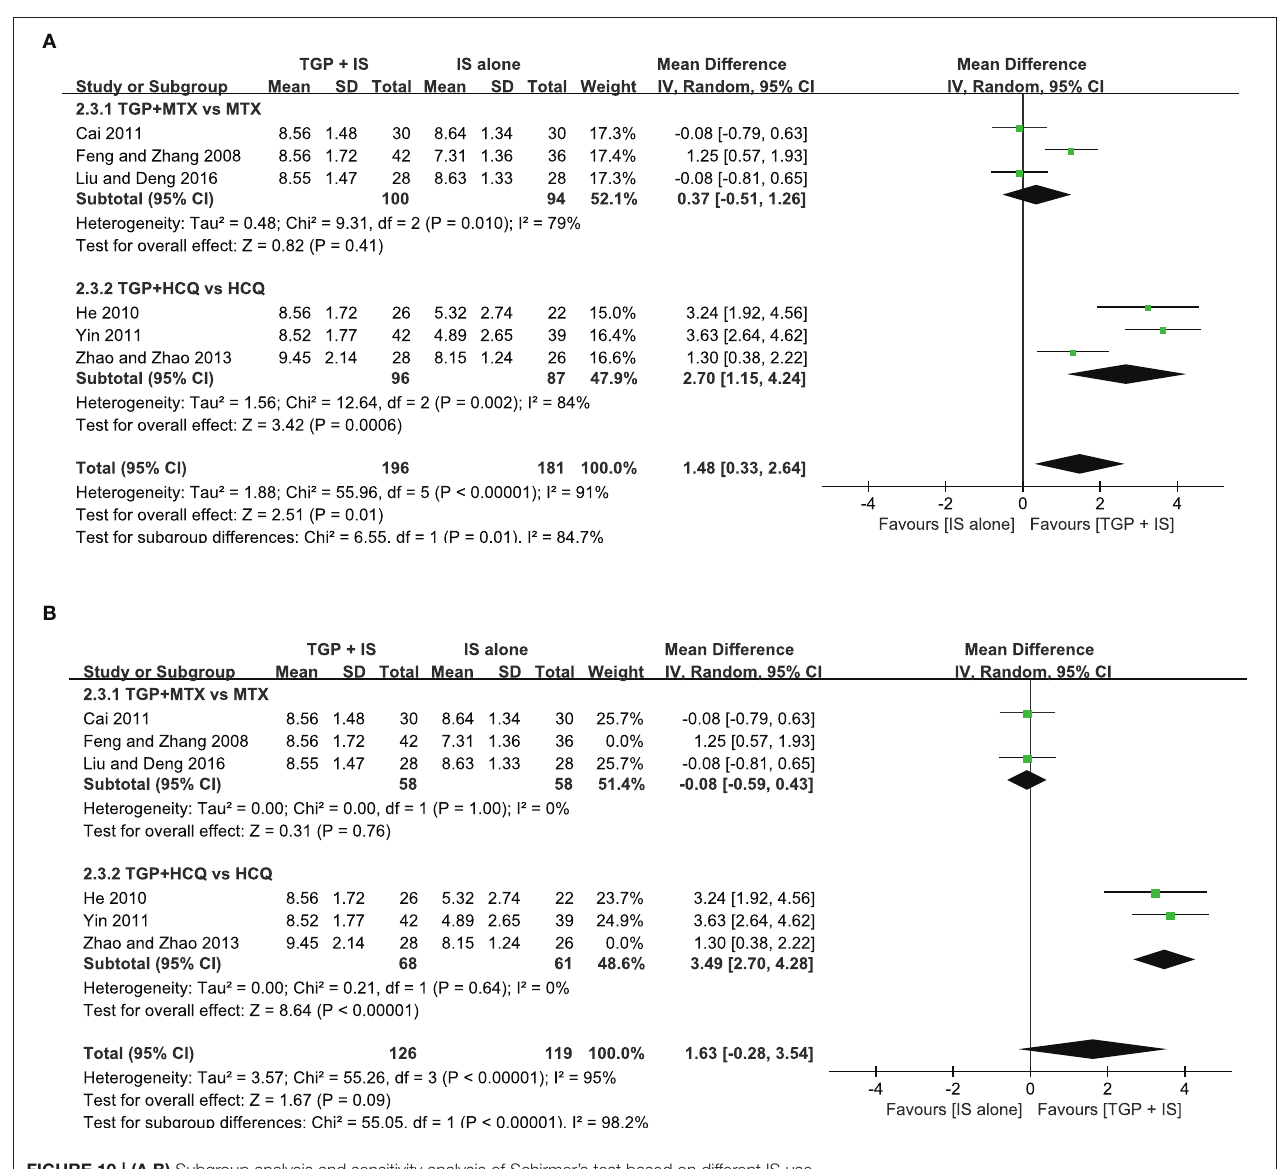
FIGURE 10 | (A,B) Subgroup analysis and sensitivity analysis of Schirmer’s test based on different IS